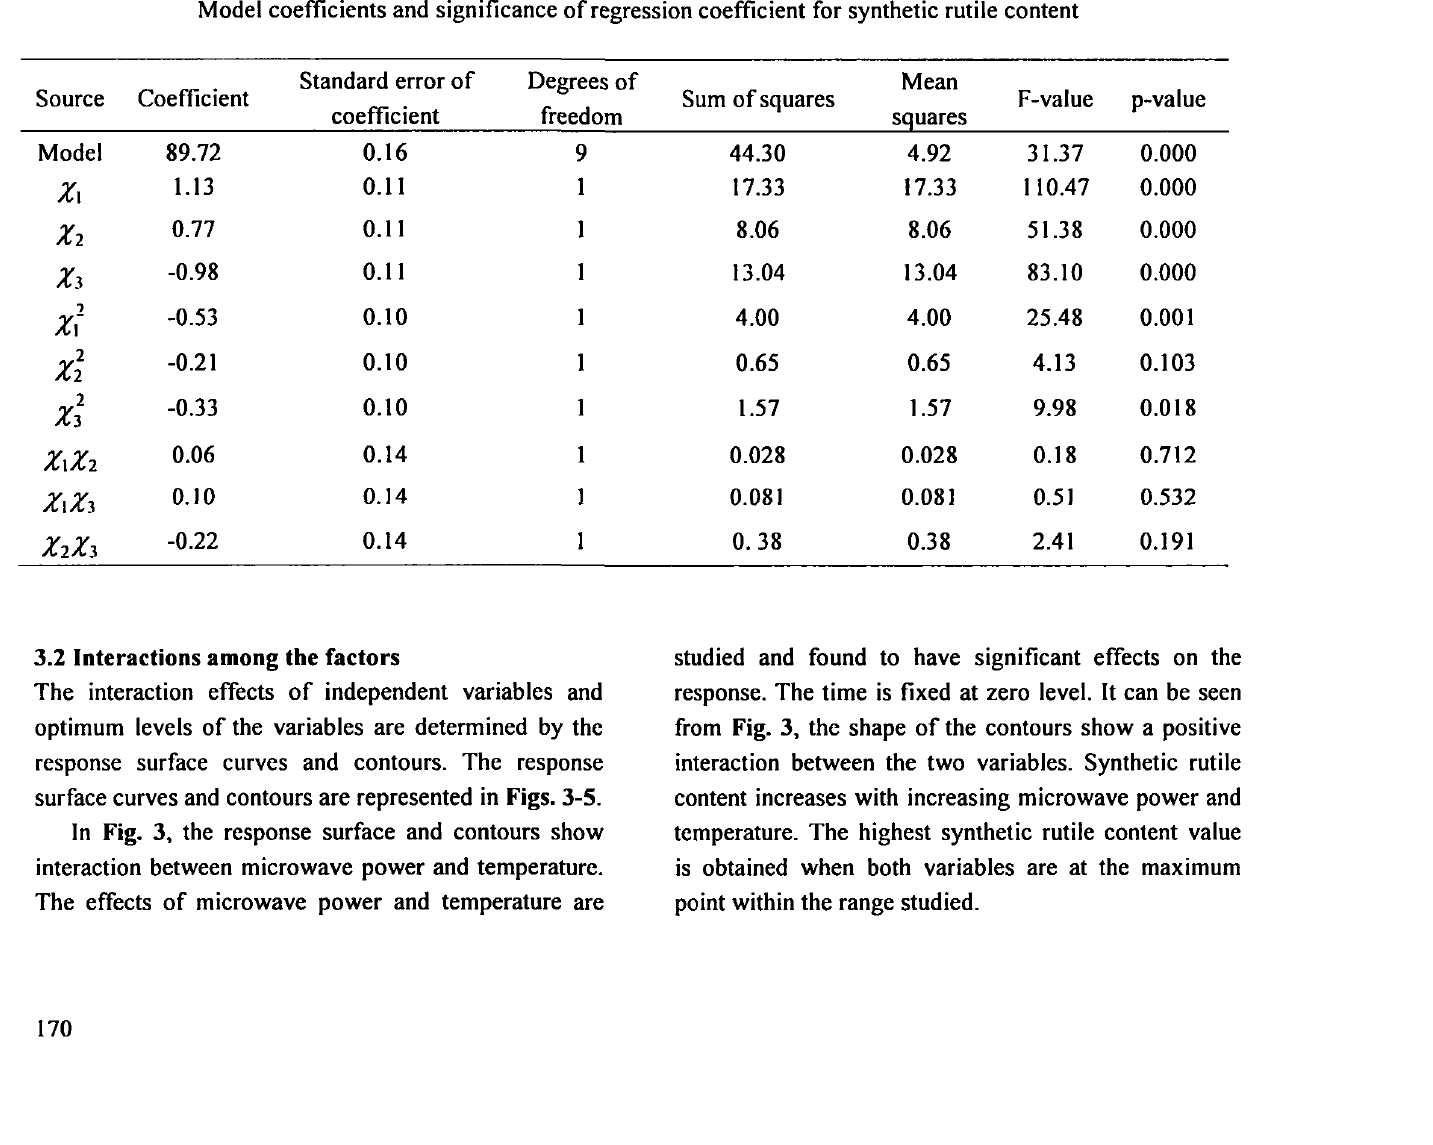
Model coefficients and significance of regression coefficient for synthetic rutile